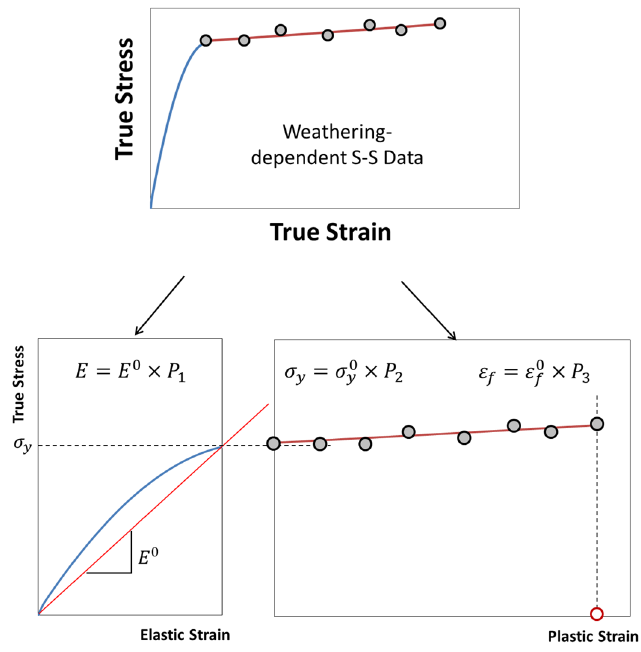
Figure 16. Scheme for generating weathering exposed material model for FE analysis using fracture strain retention value.